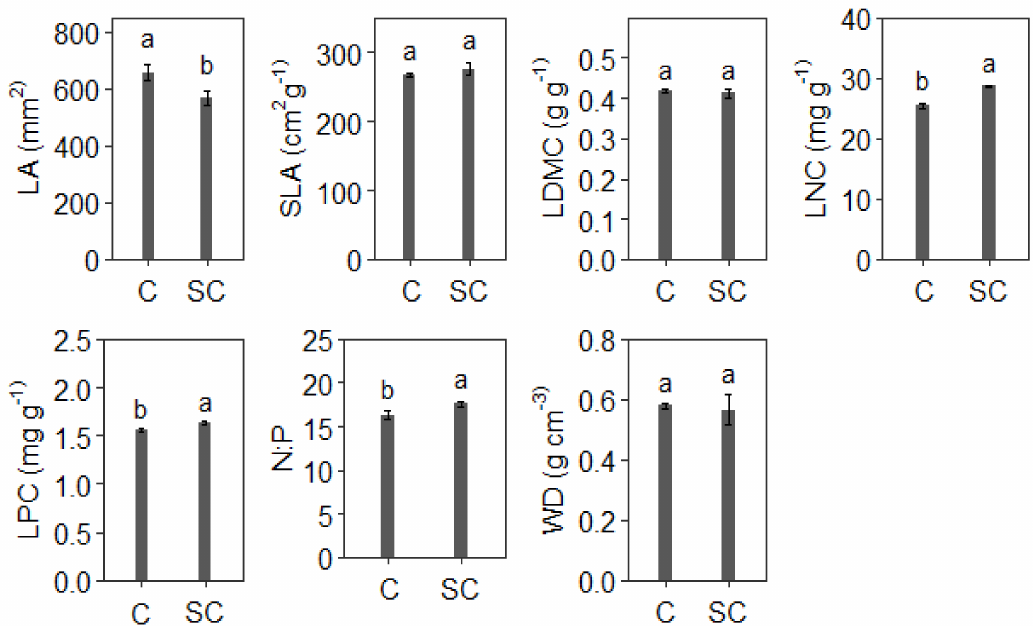
Figure 1. Leaf area (LA), specific leaf area (SLA), leaf dry matter content (LDMC), leaf nitrogen content (LNC), leaf phos- phorus content (LPC), the nitrogen-phosphorus ratio (N:P), and wood density (WD) of moso bamboo in strip clearcutting (SC) and unharvested (C) plots. Error bars indicate the standard deviation ( n = 3). Different letters indicate significant differences between the two treatment sites ( p <